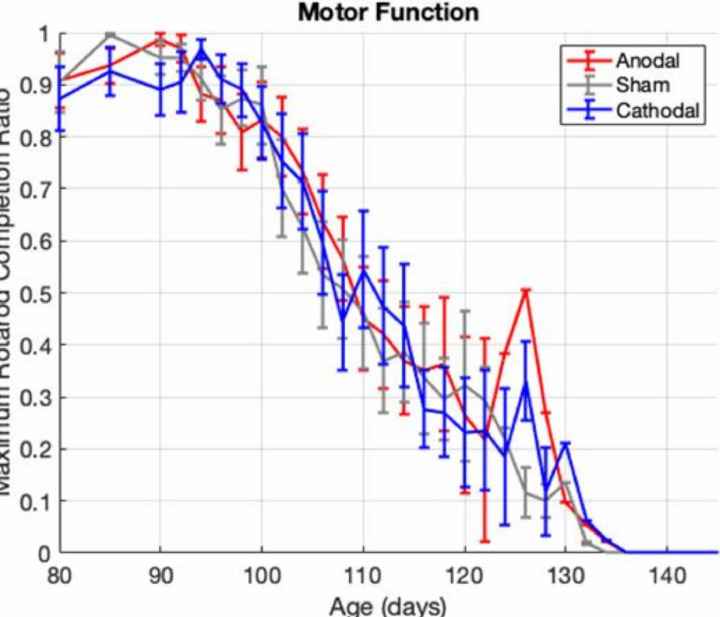
Figure 5. Group average motor function score vs age shown with standard error bars. The averages show sharp and dramatic changes in the later ages as more animals meet the end-stage running criteria and thus fewer animals remain in each group to contribute to the group average.